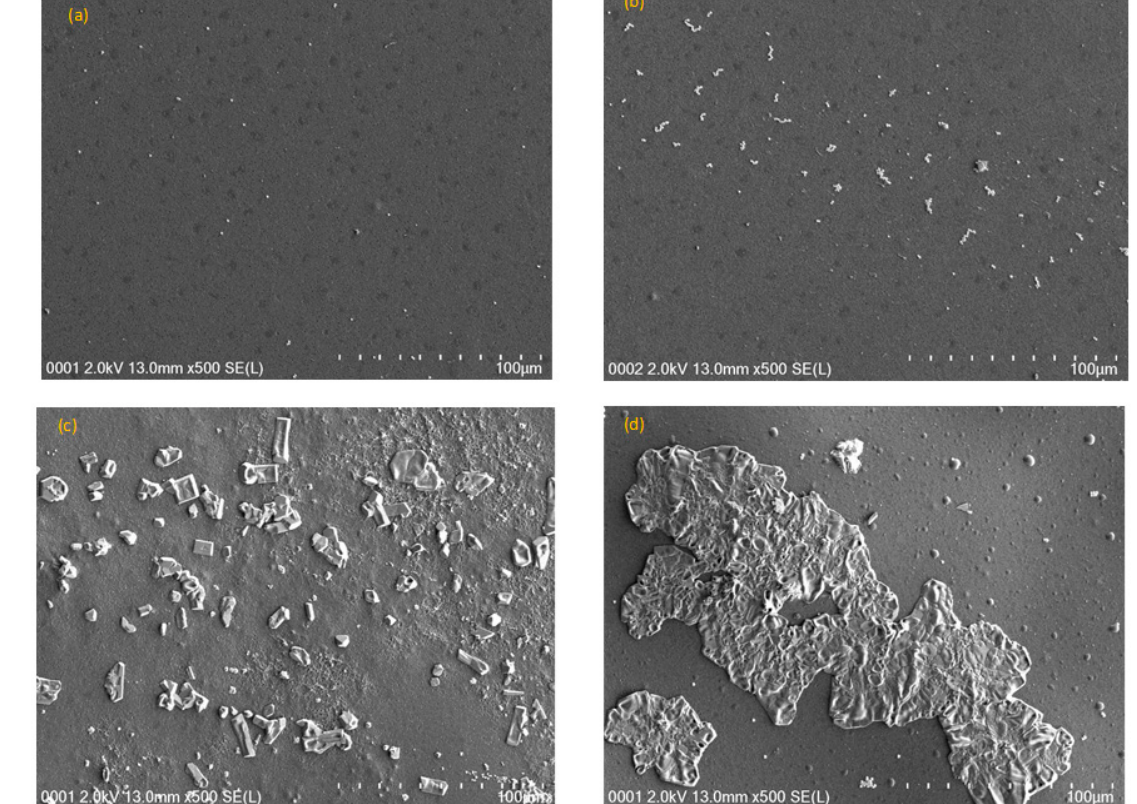
Figure 2. Field-emission scanning electron microscopy (FESEM) images for ( a ) CSPEH1, ( b ) CSPEH2, ( c ) CSPEH3 and ( d ) CSPEH4 polymer blend electrolytes.